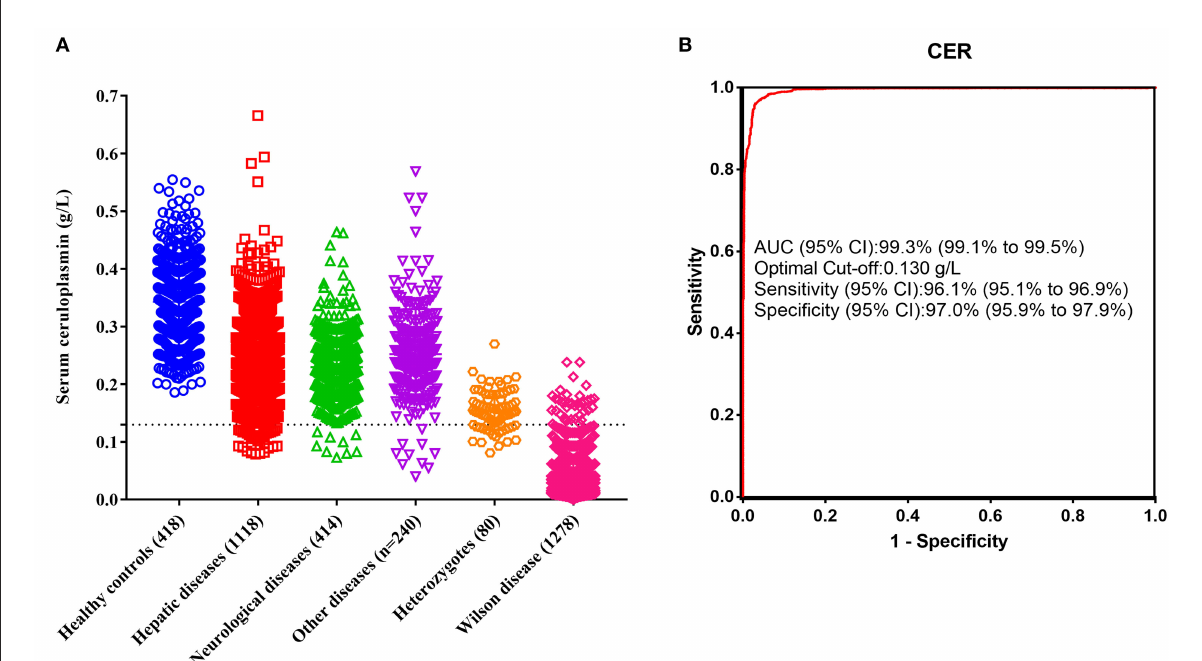
FIGURE1 Diagnostic performance of serum ceruloplasmin. (A) Comparison of serum ceruloplasmin concentrations among healthy controls, patients with hepatic diseases, patients with neurological diseases, patients with other diseases, heterozygotes, and patients with WD. (B) ROC of serum ceruloplasmin concentration for the diagnosis of